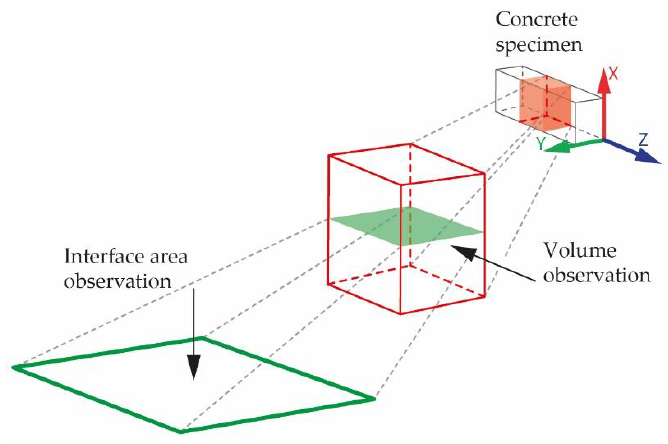
Figure 4. Direction of observation in the volumetric analysis and interface area analysis.